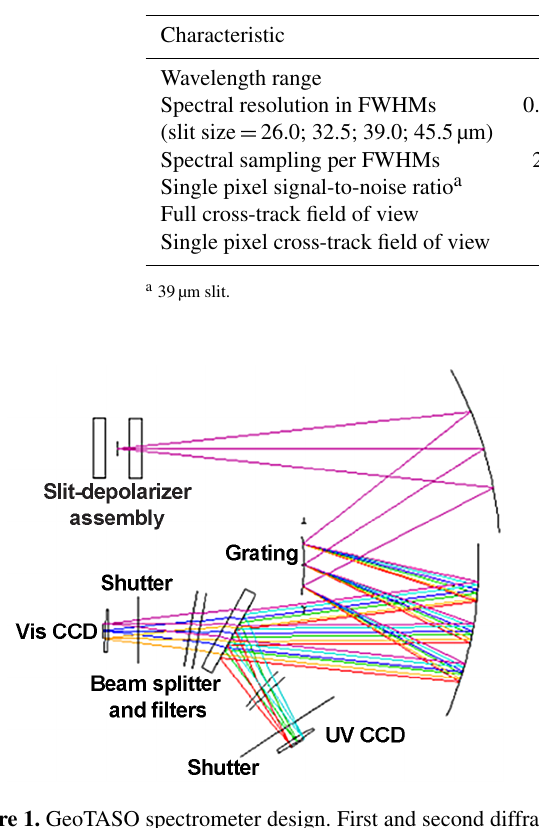
Figure 1. GeoTASO spectrometer design. First and second diffrac- tion orders are separated into Vis and UV channels by the beam splitter and filters.